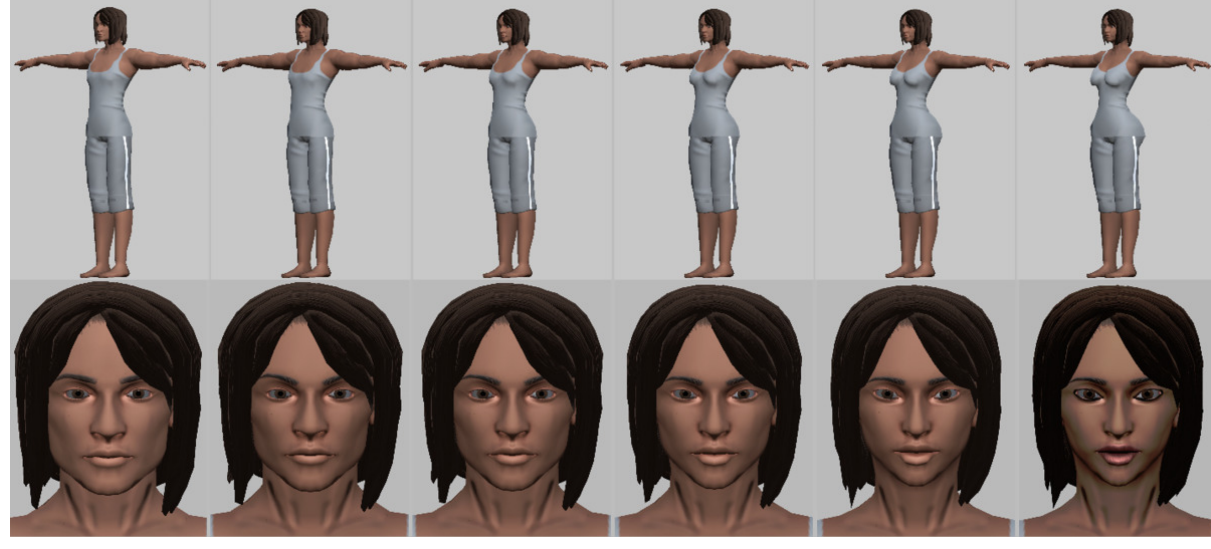
Figure 1. Draft avatar editor system showing a sample character that can transition from masculine to feminine gender